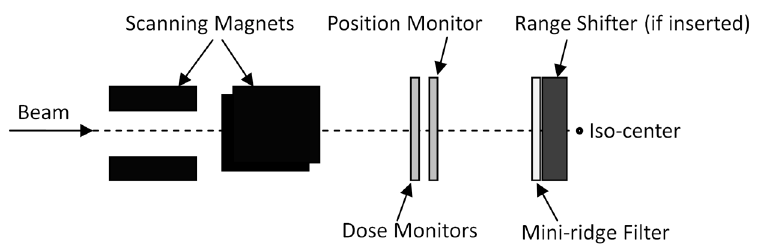
Figure 5. Schematic of the IMRF.